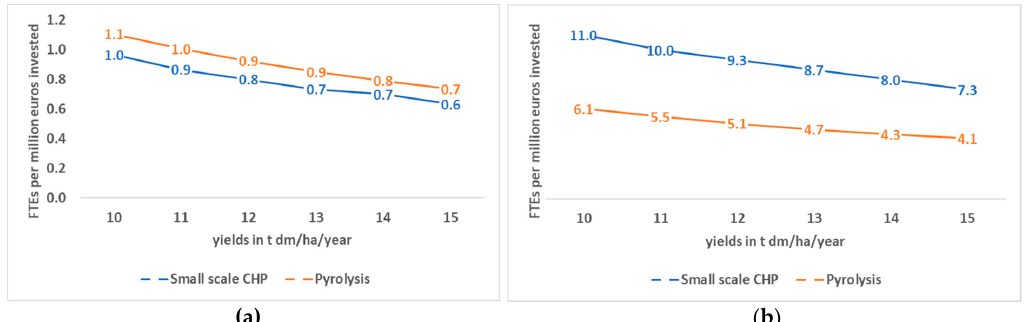
Figure 4. Net additional FTEs per million Euro investment in the reference value chains by crop yield: ( a ) direct and ( b ) indirect respectively).